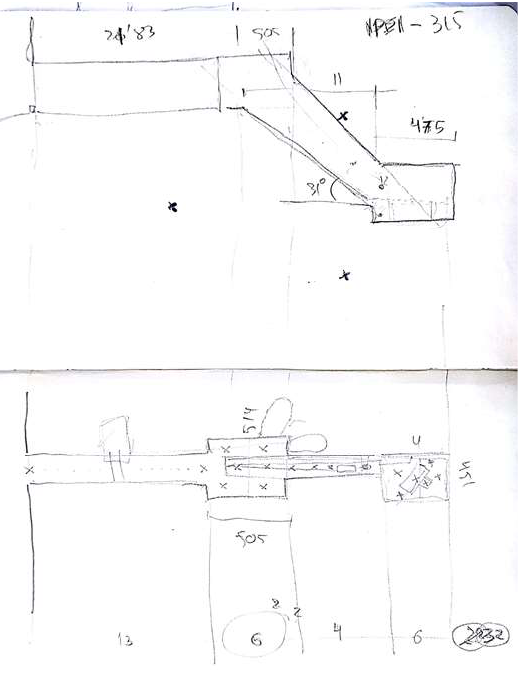
Figure 8. Hand design of Dagi’s